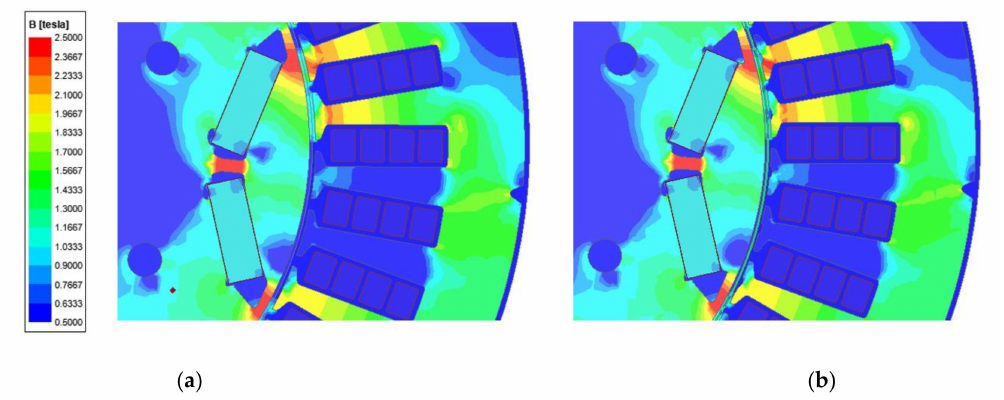
Figure 10. Flux density distribution at the load operation: ( a ) Initial model; ( b ) Optimal model.